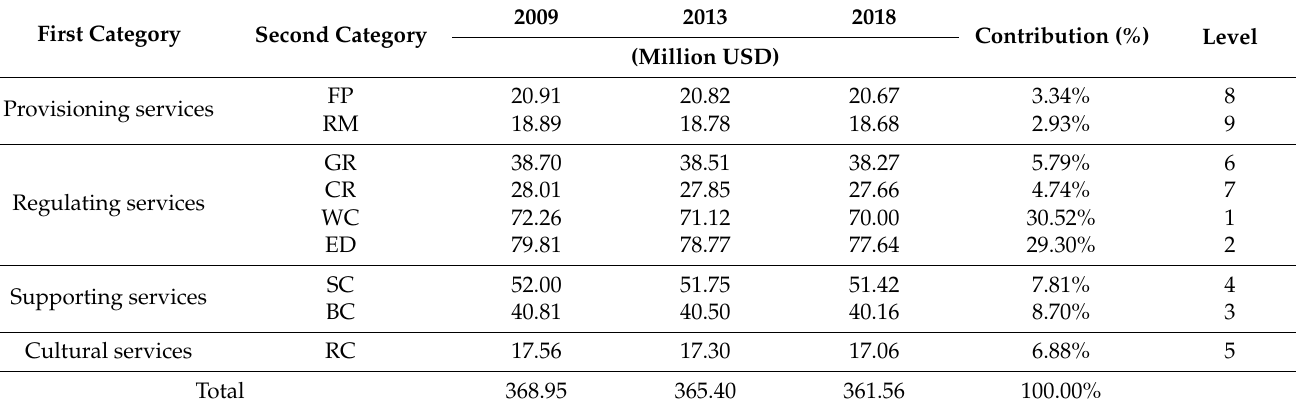
Figure 3. The ESV for different ecosystem service types in Wu’an city from 2009 to 2018. Table 3. Changes and contribution in the ESV in Wu’an City from 2009 to 2018.